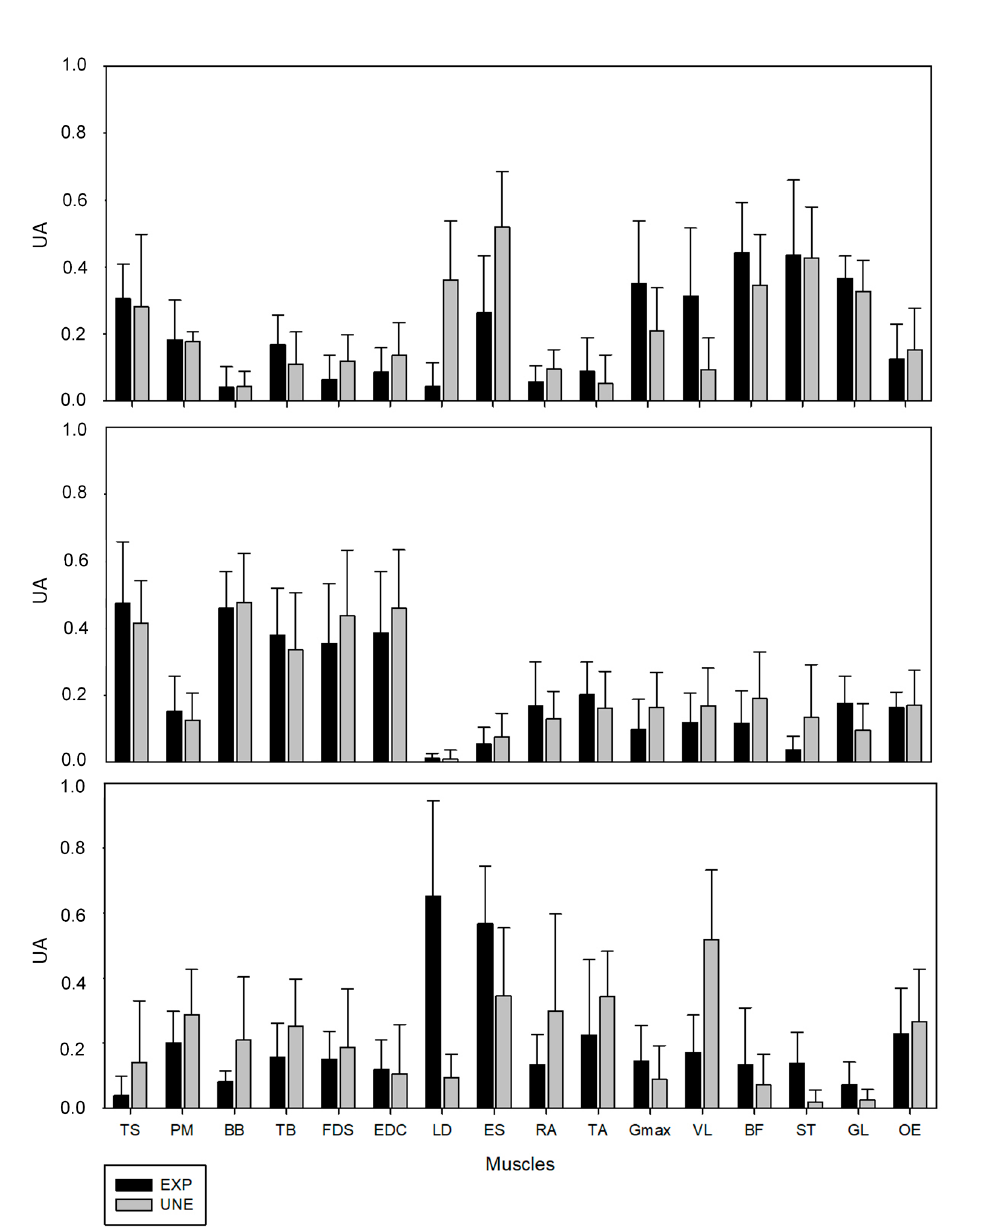
Figure 4. Averaged muscle synergy vectors of weightlifter (EXP) and unexperienced participant (UNE) groups (UA–arbitrary units). Top panel regards to Synergy #1, central panel to Synergy #2, and bottom panel to Synergy #3. Table 1. Intra-group and inter-group similarity values (r) of muscle synergy vectors of weightlift- ers (EXP) and unexperienced participants (UNE). Intra-Group